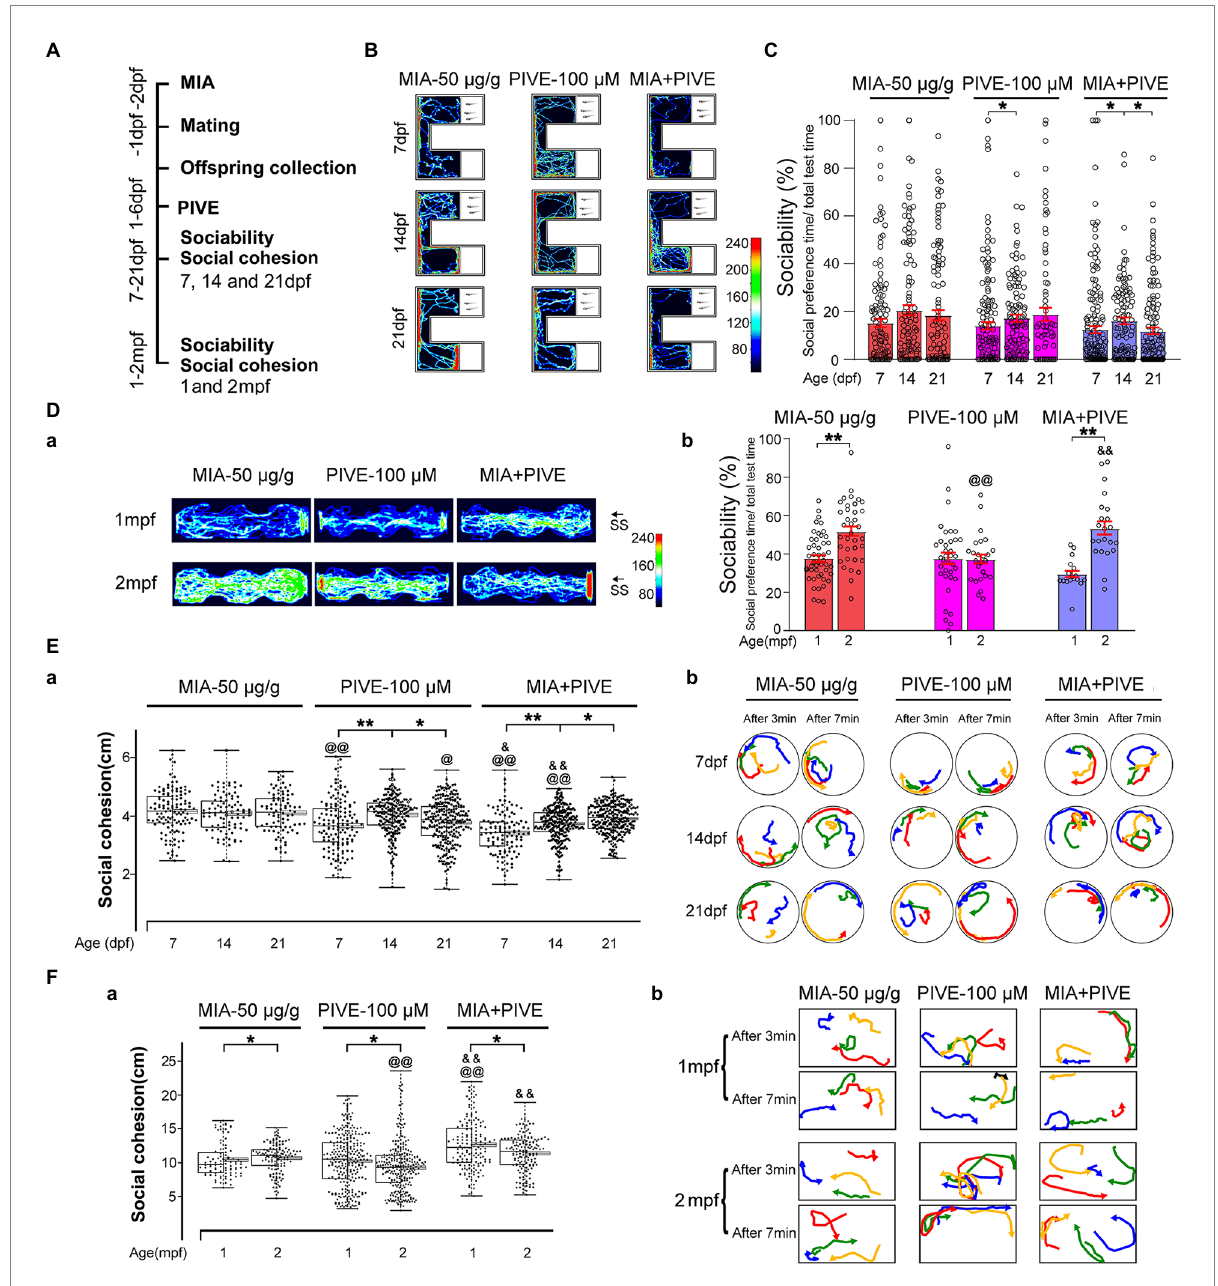
FIGURE 4 MIA combined with PIVE impaired social approach and decreased social cohesion. (A) Zebrafish were tested for sociability and social cohesion at 7, 14, and 21 dpf, and 1 and 2 mpf after MIA + PIVE. (B) Video tracking of movements of MIA + PIVE larvae at 7, 14, and 21 dpf, showing the social interaction with the social cue. (C) Sociability of MIA + PIVE larvae at 7, 14, and 21 dpf. MIA + PIVE did not further impair the sociability at 7, 14, and 21 dpf. (Da) Video tracking of movements of MIA + PIVE fish at 1 and 2 mpf, showing the social interaction with the social cue. (Db) Sociability of MIA + PIVE fish at 1 and 2 mpf. Although the sociability in the MIA + PIVE group decreased at 1 mpf, but not statistically significant. (Ea,Fa) MIA + PIVE induced an increased social cohesion at 7 and14 dpf ( Z = 4.73, 4.32, and 3.16, p < 0.01, 0.01 and 0.05, respectively, for 7, 14, and 21 dpf vs. MIA-50 μ g/g; Z = 2.55 and 5.55, p < 0.05 and 0.01, respectively, for 7 and 14 dpf vs. PIVE-100 μ M), and a decreased social cohesion at 1 and 2 mpf ( Z = 4.61, p < 0.01 for 1 mpf vs. MIA-50 μ g/g; Z = 5.40 and 6.89, p all <0.01 for 1 and 2 mpf vs. PIVE-100 μ M). (Eb,Fb) Tracking of individual fish in a group of four fish show impaired social cohesion in MIA + PIVE fish. Data are presented as mean ± SEM. * p < 0.05, ** p < 0.001; @ p < 0.05 ， @@ p < 0.001 compared with the MIA-50 μ g/g group of the same age. & p < 0.05, && p < 0.001 compared with the PIVE-100 μ M group of the same age. Detail about the n and descriptive data for each group and statistical analysis results could be found in Additional file 11: File